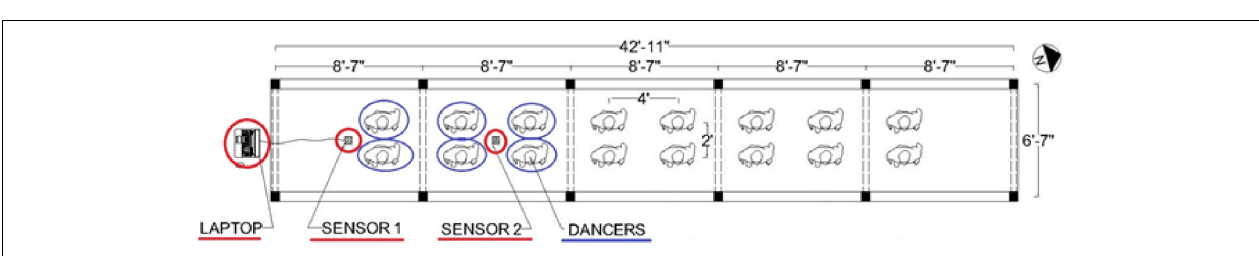
FIGURE 3 | Footbridge plan view arrangement of dancers and sensors (dancers an shoulders of dancers are facing east from above).